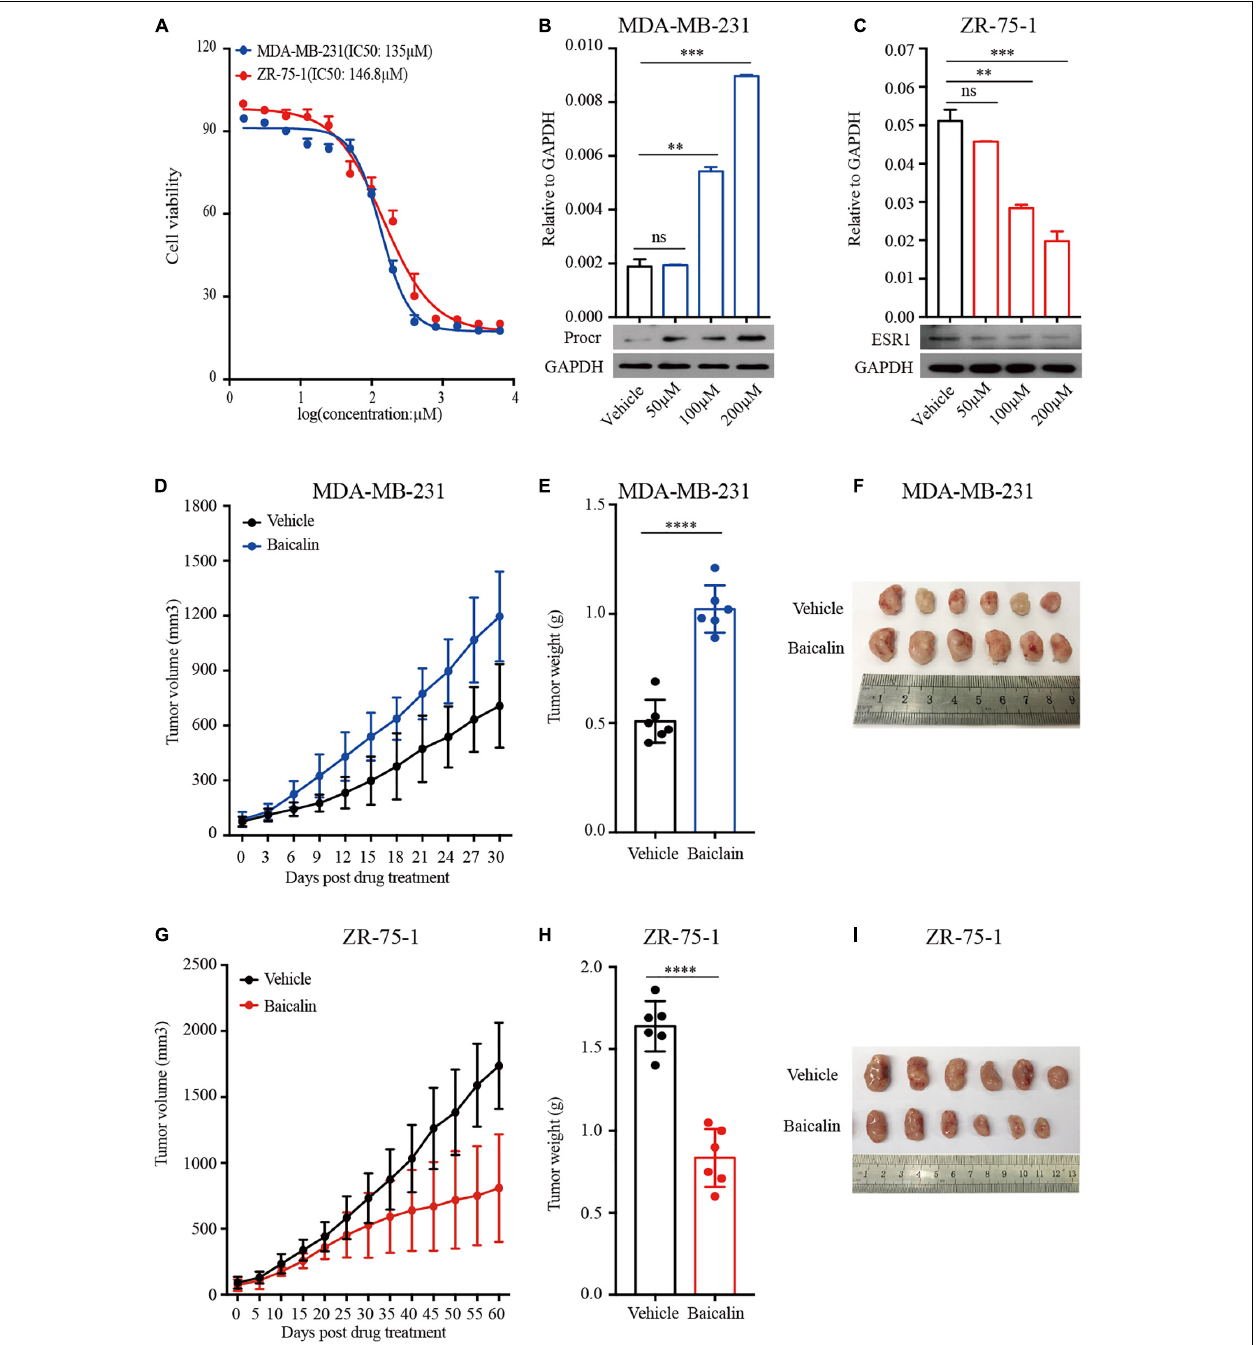
FIGURE 7 | Baicalin promotes the growth of TNBC tumors and suppresses the growth of luminal breast cancer tumors. (A) An MTT assay was performed on MDA-MB-231 and ZR-75-1 cells treated with baicalin. (B) RT-qPCR and western blot analyses were performed to detect PROCR expression in MDA-MB-231 cells treated with baicalin. Data are presented as mean ± SD from three independent experiments. Student’s t -test: ∗∗∗ P < 0.001; ∗∗ P < 0.01; ns, not significant. (C) RT-qPCR and western blot analyses were performed to detect ESR1 expression in ZR-75-1 cells treated with baicalin. Data are presented as mean ± SD from three independent experiments. Student’s t -test: ∗∗∗ P < 0.001; ∗∗ P < 0.01; ns, not significant. (D) Effect of baicalin on tumor volume in an MDA-MB-231 xenograft mouse model. The data are representative results obtained from more than five mice. (E) Effect of baicalin on tumor weight in an MDA-MB-231 xenograft mouse model. The data are representative results obtained from more than five mice. Student’s t -test: ∗∗∗∗ P < 0.001. (F) A representative MDA-MB-231 tumor at the end of the experiment. (G) Effect of baicalin on tumor volume in a ZR-75-1 xenograft mouse model. The data are representative results obtained from more than five mice. (H) Effect of baicalin on tumor weight in a ZR-75-1 xenograft mouse model. The data are representative results obtained from more than five mice. Student’s t -test: ∗∗∗∗ P < 0.001. (I) Representative ZR-75-1 tumor at the end of the experiment.